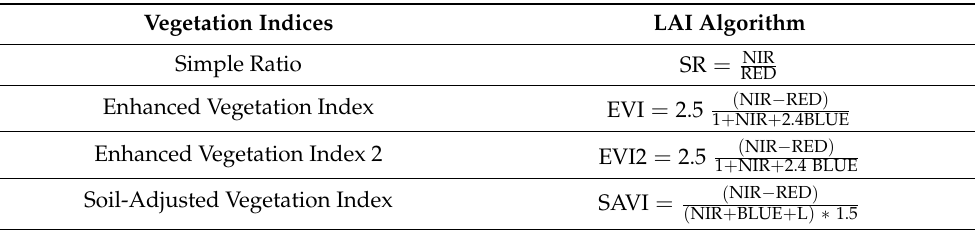
Table 2. Vegetation indices used in this study. NIR, RED, GREEN, and BLUE represent Landsat 8 bands 5, 4, 3, and 2, respectively. L represents the amount of green vegetation cover.